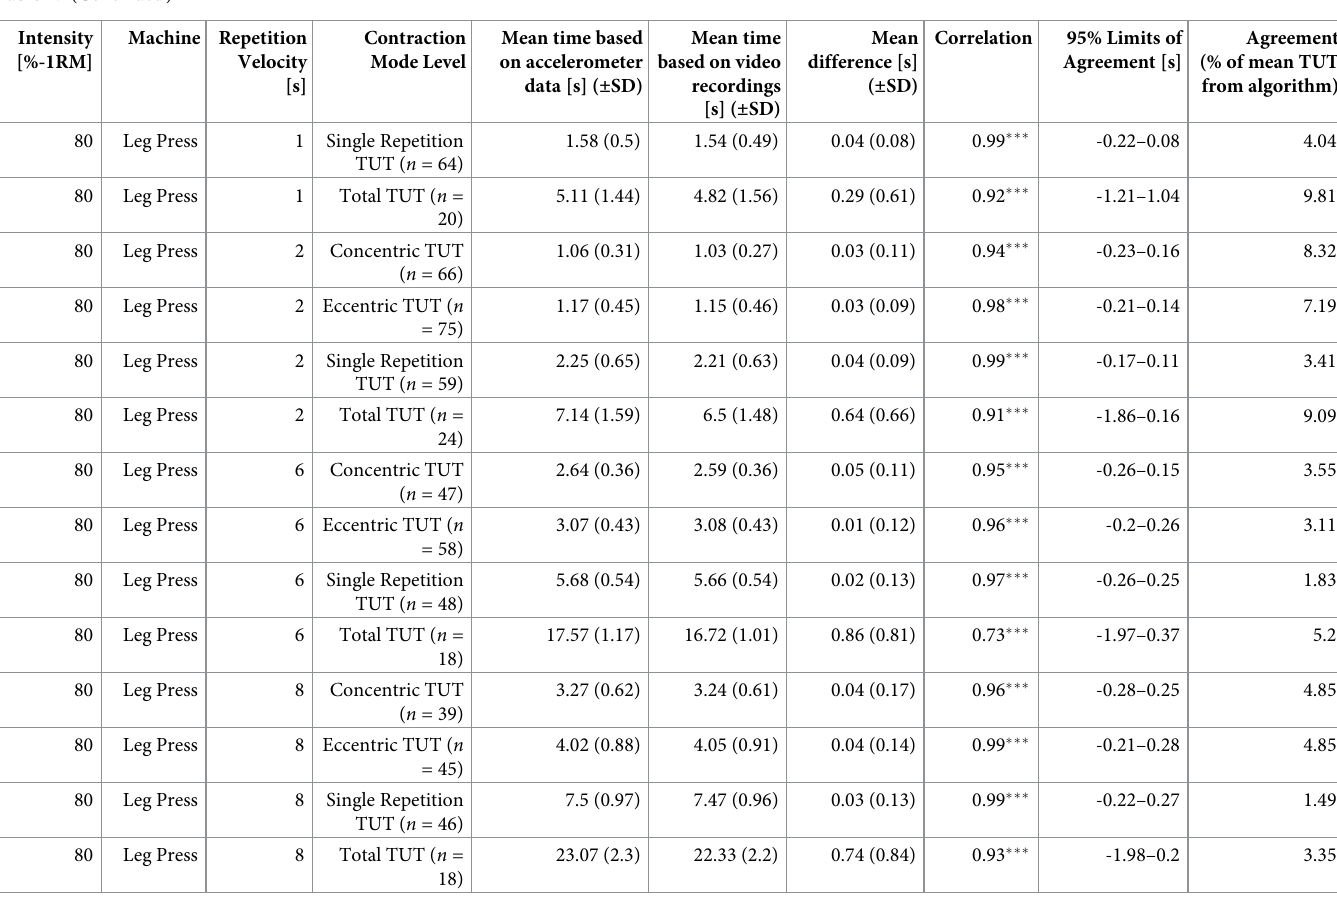
algorithm by Viecelli et al . [17], velocities of 1 s, 2 s, 6 s and 8 s per repetition were chosen.